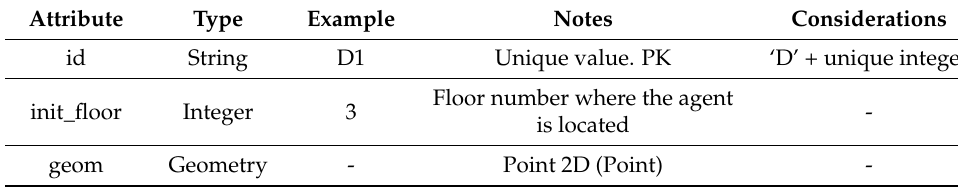
Table A5. GIS attribute table of